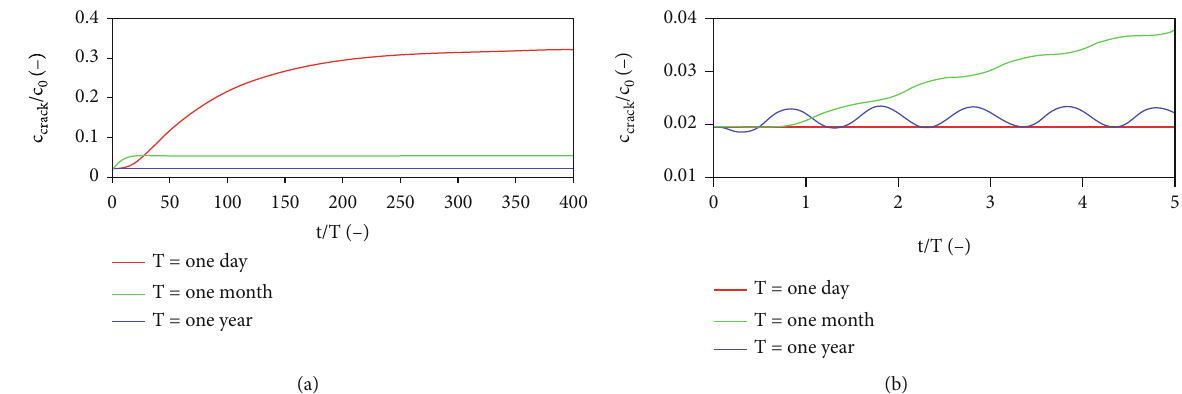
Figure 8: The variation of normalized gaseous TCE concentration at the crack for the cases with A = 0 : 2 m and di ff erent fl uctuation periods ( T =one day, one month, and one year): (a) 400 periods and (b) 5 periods.